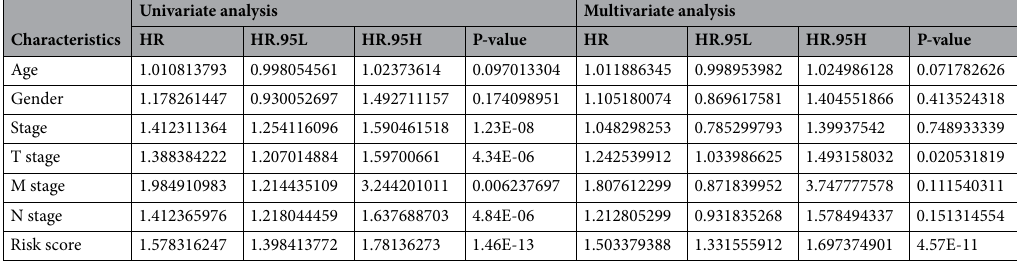
Table 3. Univariate and multivariate analyses with Cox proportional hazard model. HR hazard